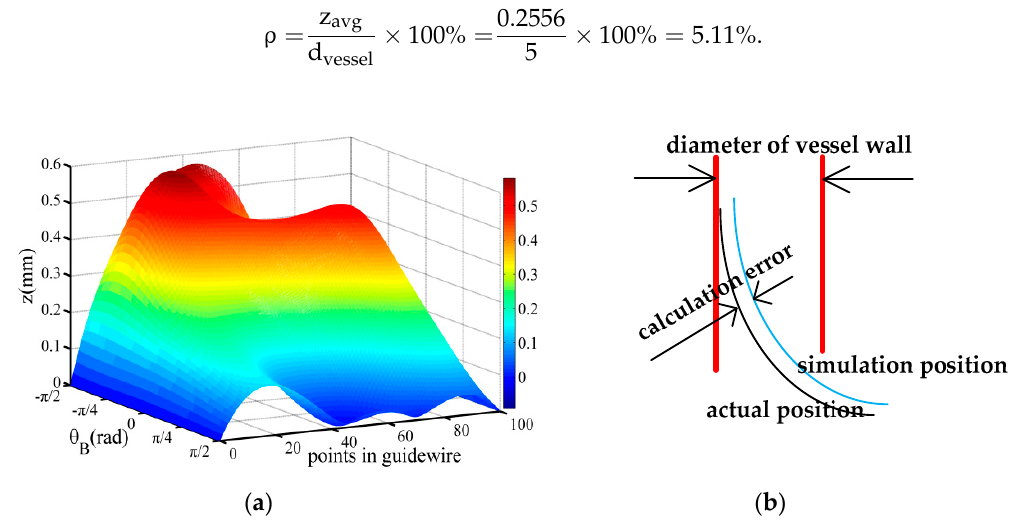
Figure 9. ( a ) Calculation error for the two point-contact guidewire; ( b ) Physical meaning of